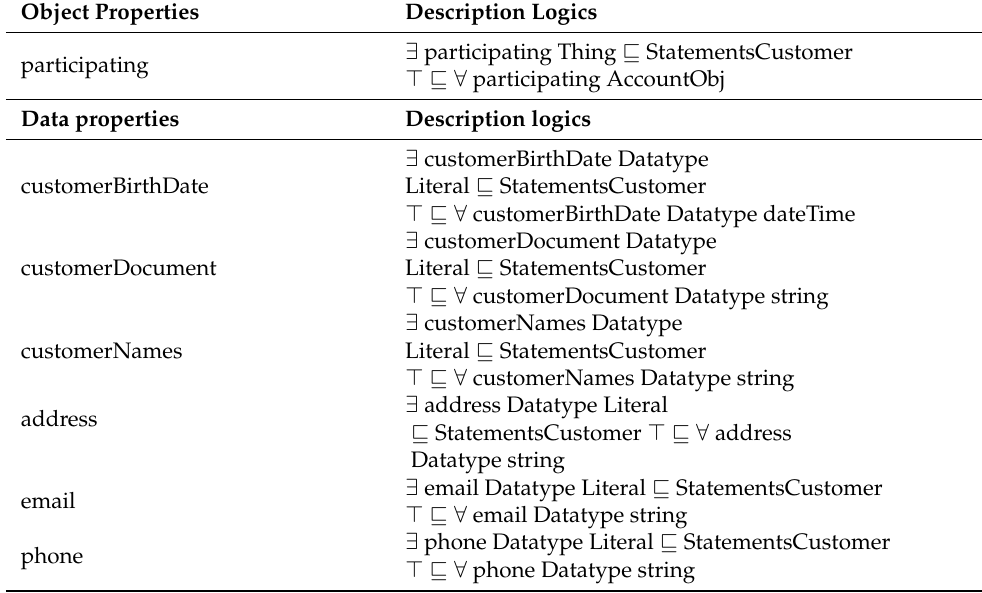
Table 6. Data and object properties of class